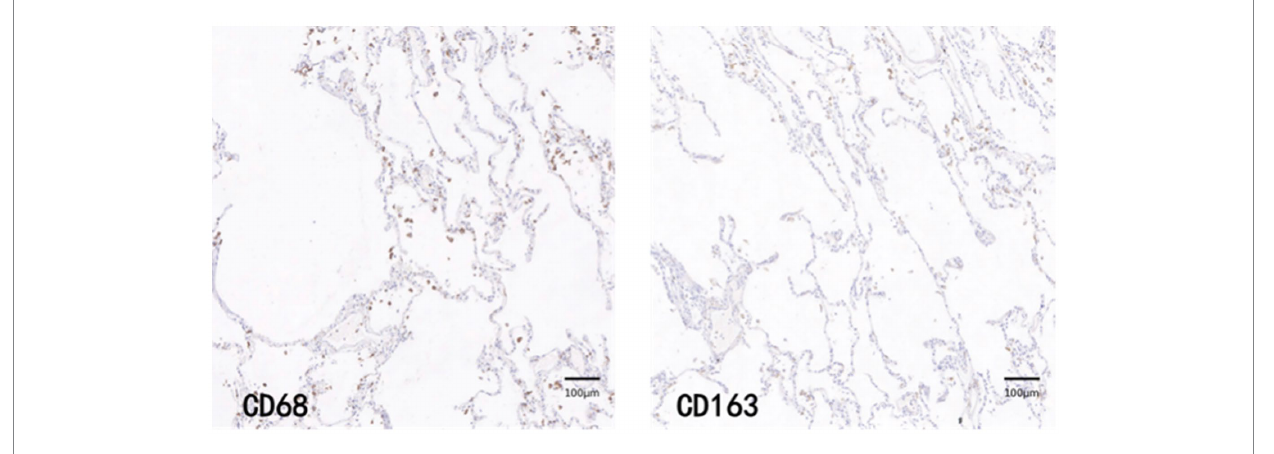
FIGURE 12 Control immunohistochemical staining PATCH (1,600 × 1,600 pixels).